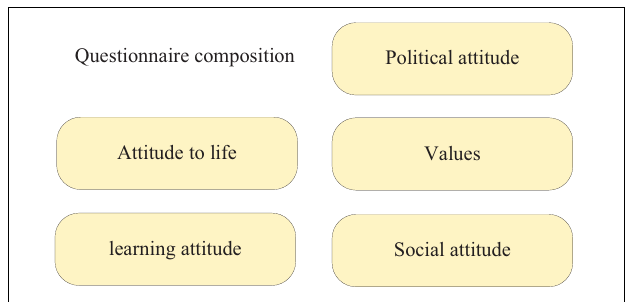
FIGURE 1 | Questionnaire